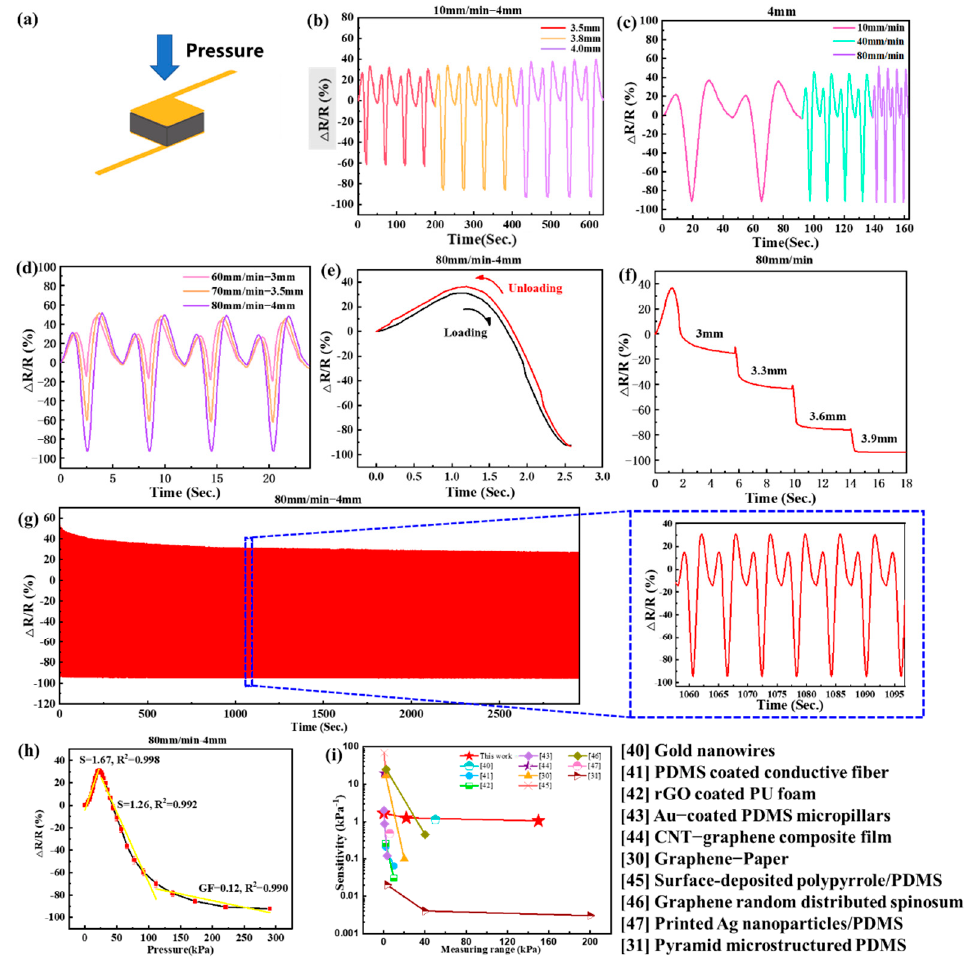
Figure 4. Single PGSPS performance test. ( a ) Schematic illustration of a PGSPS under pressure. ( b ) Different compression ranges test at the same speed. ( c ) Same compression range test at different speeds. ( d ) Different compression ranges test at different speeds. ( e ) Recovery curve of the PGSPS under exact range and speed. ( f ) Step compression test under exact speed. ( g ) Three thousand cycle tests under exact range and speed, five of these cycles are zoomed in on the right. ( h ) Gauge factor of the PGSPS in the working range. ( i ) Comparison of sensitivity–pressure characteristics with other flexible pressure sensors.